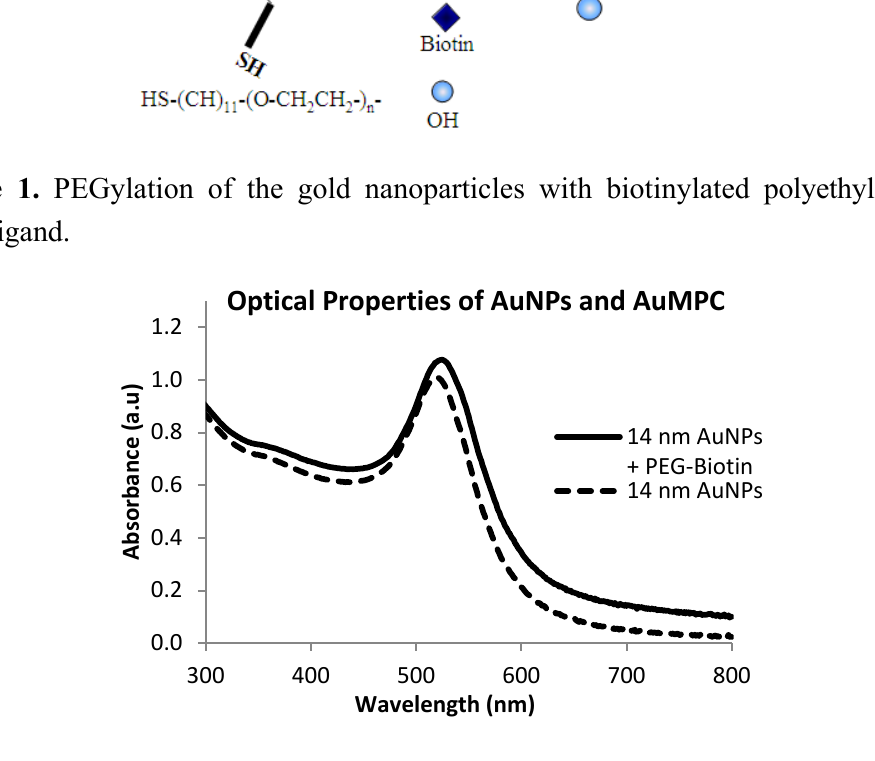
Figure 2. UV-vis spectrum of 14 nm AuNPs and PEG-biotin functionalised mononuclear protected clusters